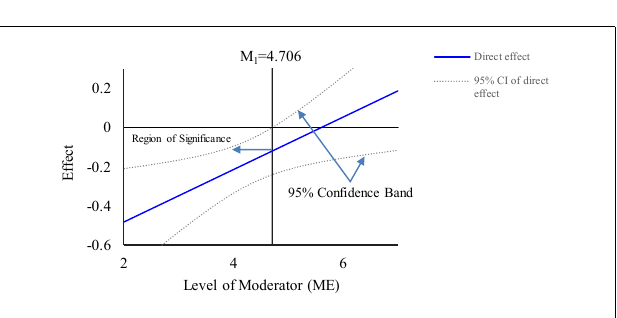
FIGURE 7 | Moderated effect of ME on the direct